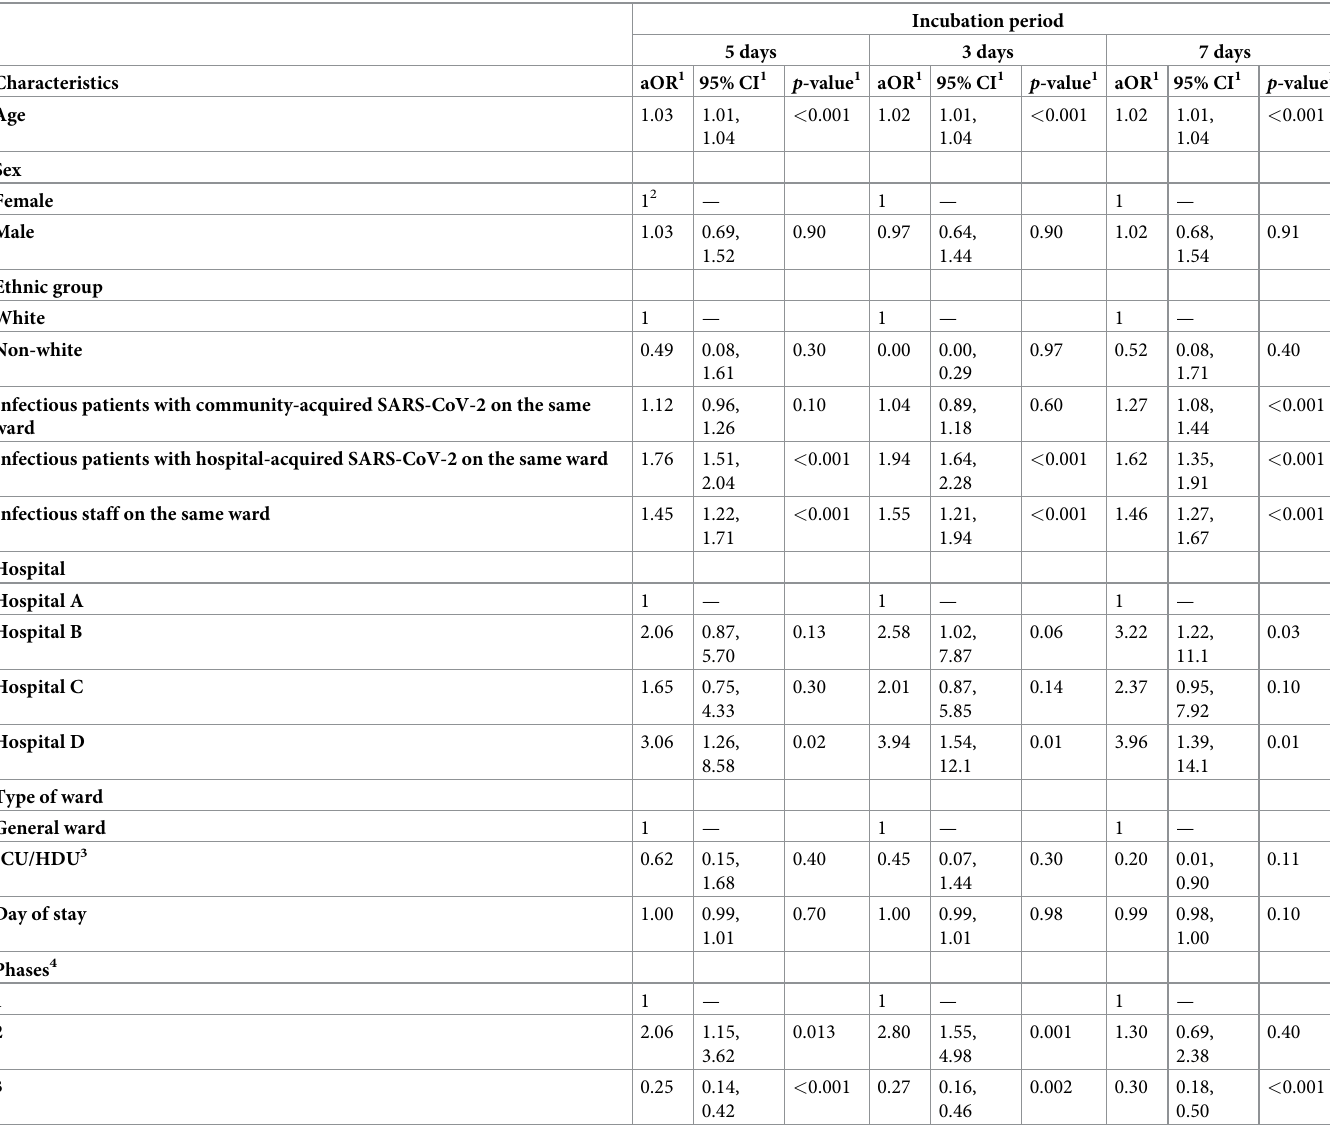
Table 3. Predictors of SARS-CoV-2 infection in admitted patients during their hospital stay from multivariable logistic regression